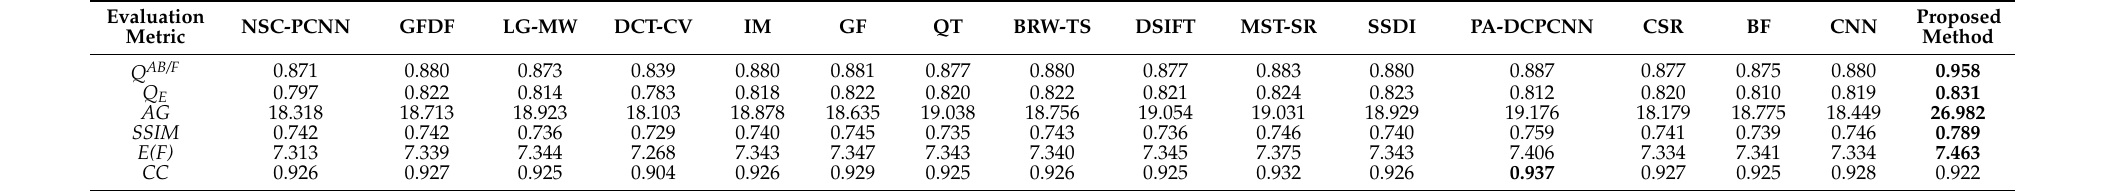
Table 32. The outcomes for the leaf image and comparisons with existing techniques in the literature ([30]).